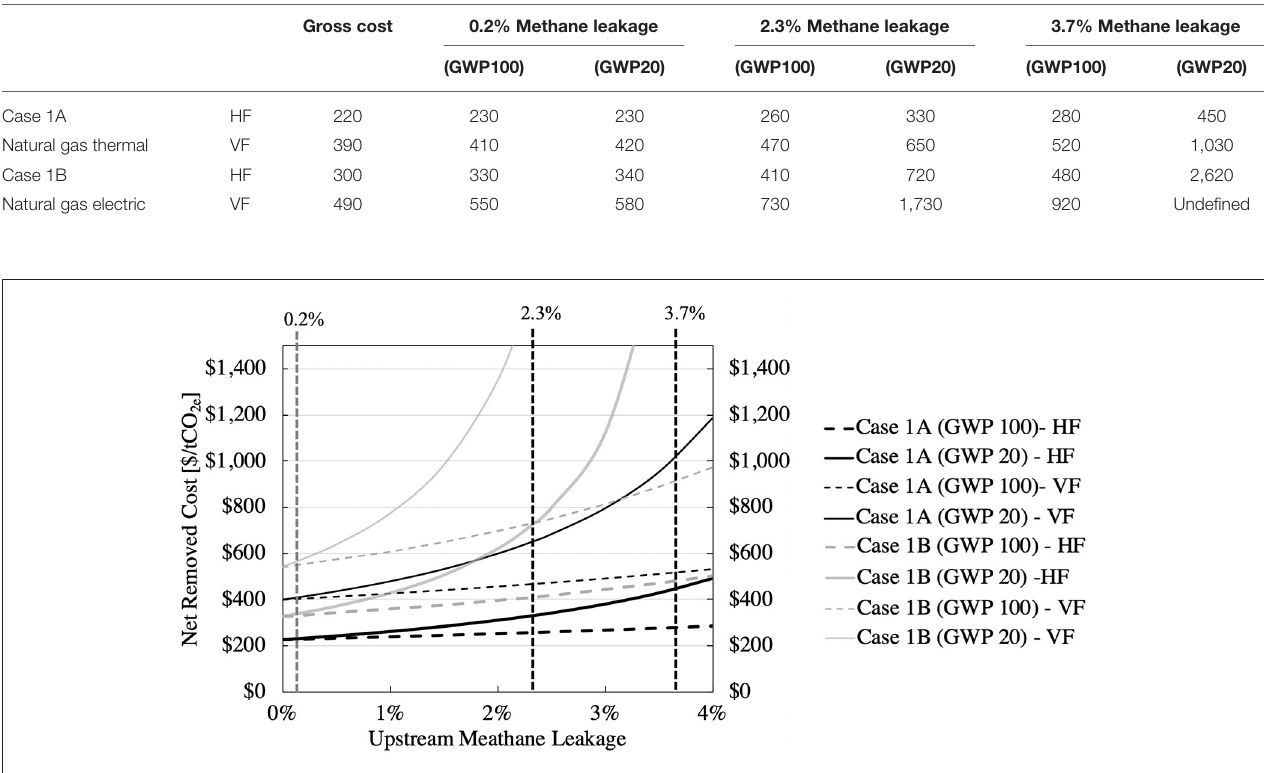
Equation (2), is 1.47. And, since the gross cost is $220/t CO 2 , the net cost is $323/t CO 2 , in agreement (when rounding errors are taken into account) with the $330/t CO 2 entry in Table 4 .